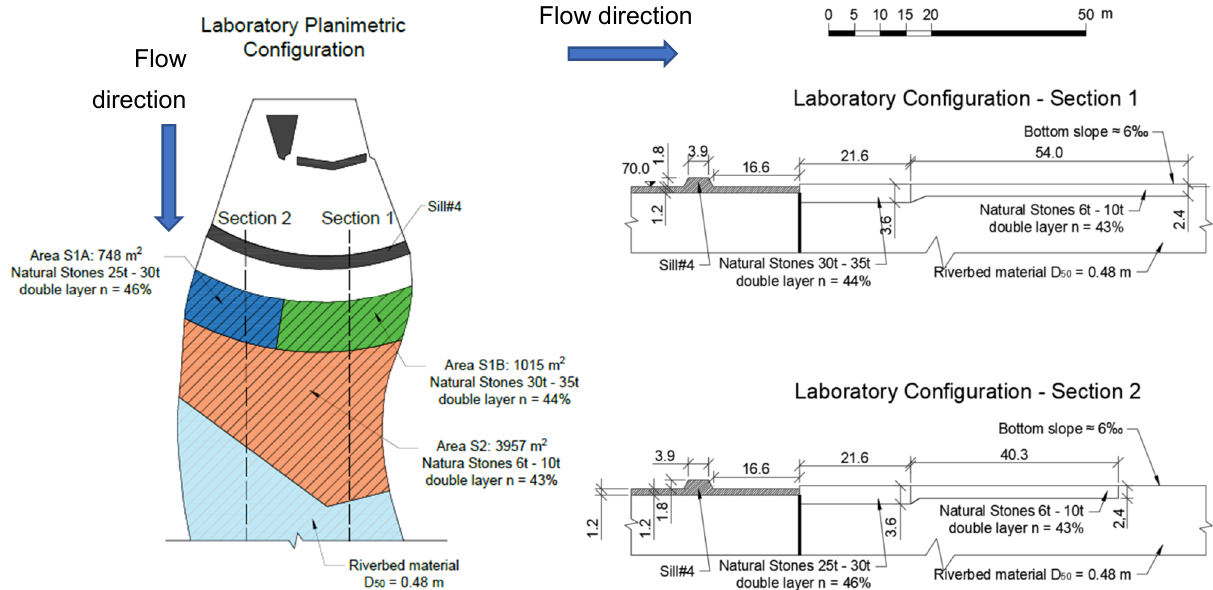
Figure 6. Scheme of the model in which the protection of the riverbed is realized with natural stones placed downstream of the stilling basin. Dimensions in prototype scale.